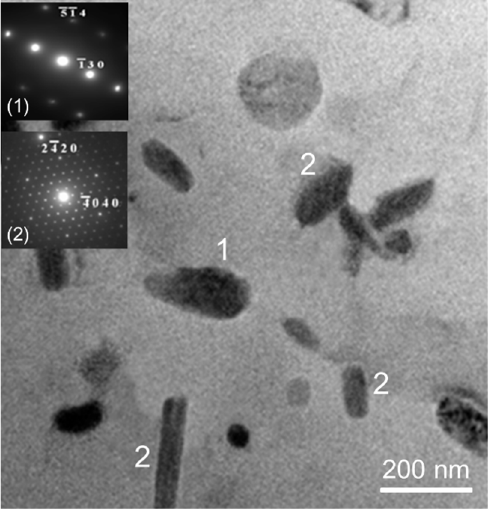
Figure 7. TEM photomicrograph of alloy D after homogenization treatment (1: MnAl 6 , 2: MnAl 4 ).